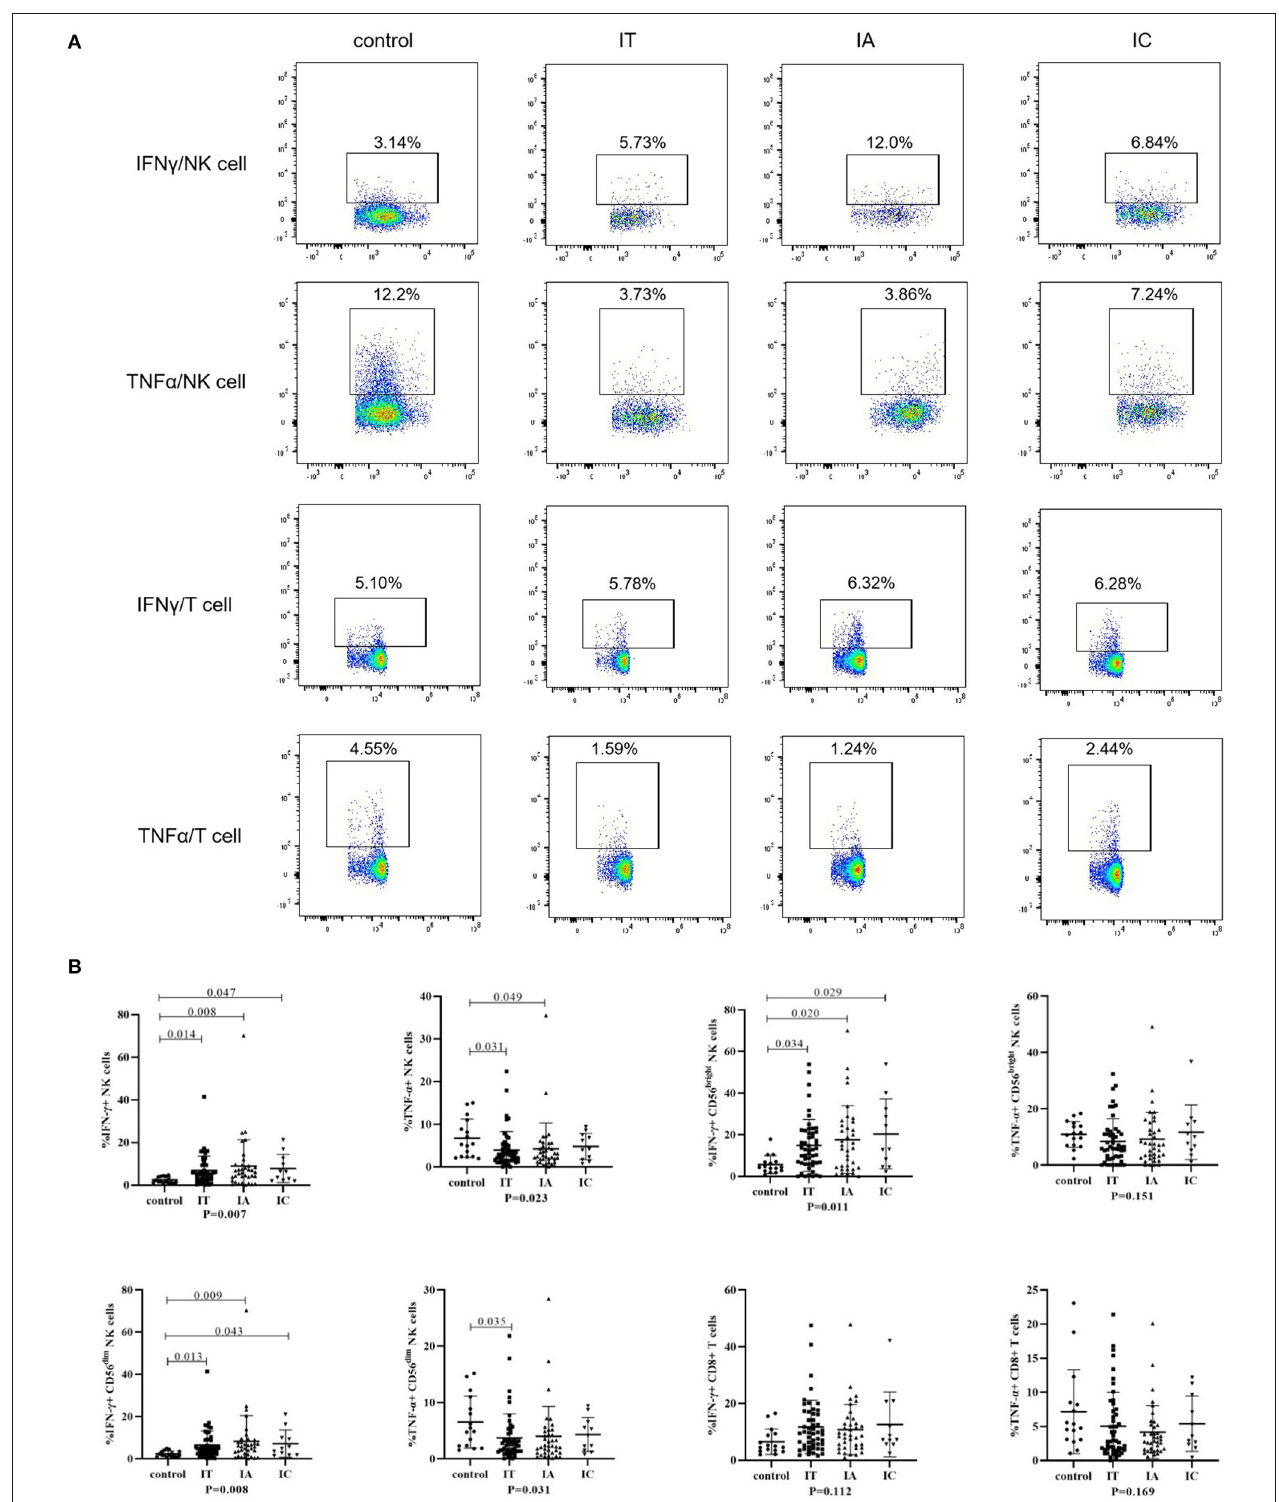
FIGURE 3 | Cytokine-producing ability of NK cells and T cells in different clinical phases. (A) Representative flow dot plots of IFN γ and TNF α produced by NK cells and CD8 + T cells. (B) Frequencies of IFN γ and TNF α produced by NK cells and CD8 + T cells. The p -values below the abscissa represent the results of the Kruskal–Wallis test of the four groups. Numbers above the lines represent the p -values of the multiple pairwise comparison with statistical significance. p < 0.05 is considered statistically significant.